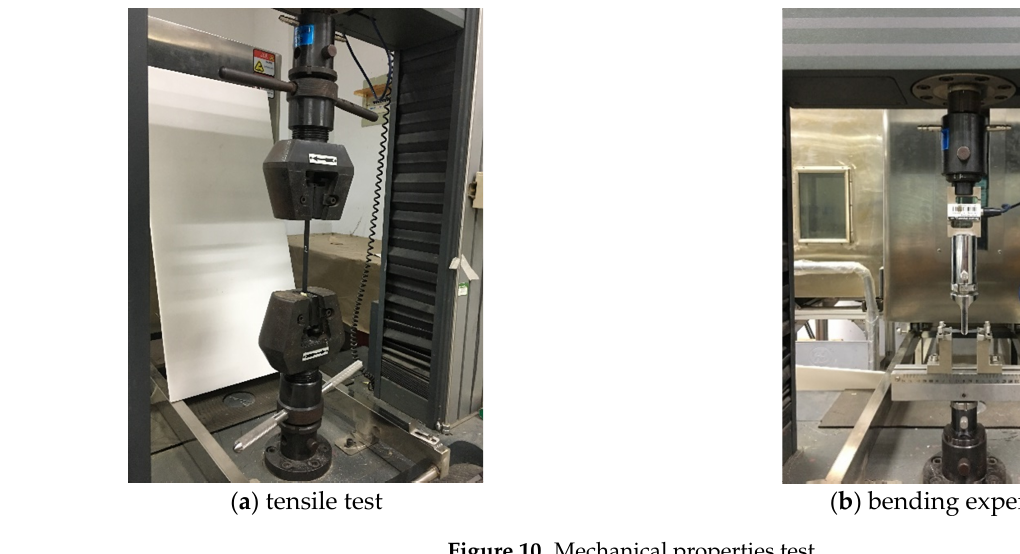
Figure 10. Mechanical properties test.